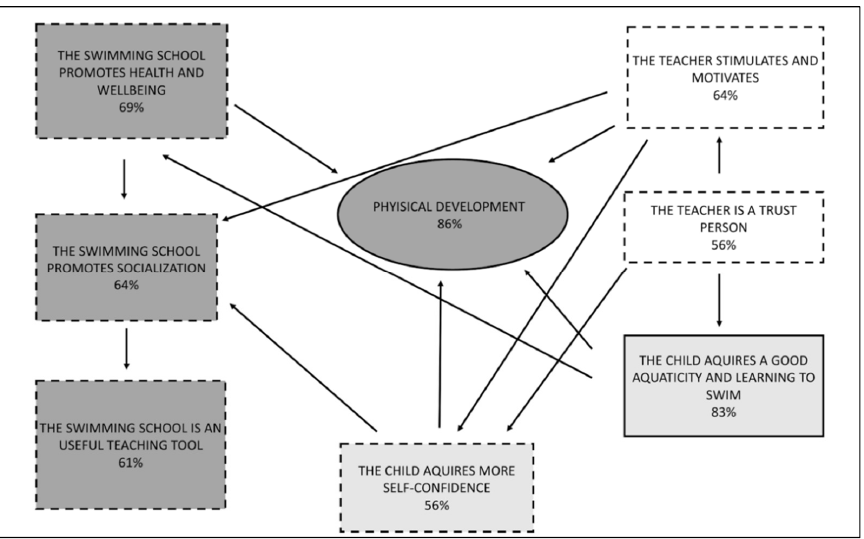
Figure 1. Representation of the themes emerged from the semi-structured interview with parents about considerations related to swimming school and swimming course attended by the children. The core category is represented at the center, in the ellipse with the continuous edge. Rectangles with continuous edges represented the category with the most frequent labels (>75%), those with dashed edges the category with a frequency between 50% and 75%. The dark grey indicates physi- cal literacy’s dimension, the light grey stands for the children’s size, and the white is associated to the instructor’s sphere. The categories with a less frequent labels (<50%) were not considered in the study.